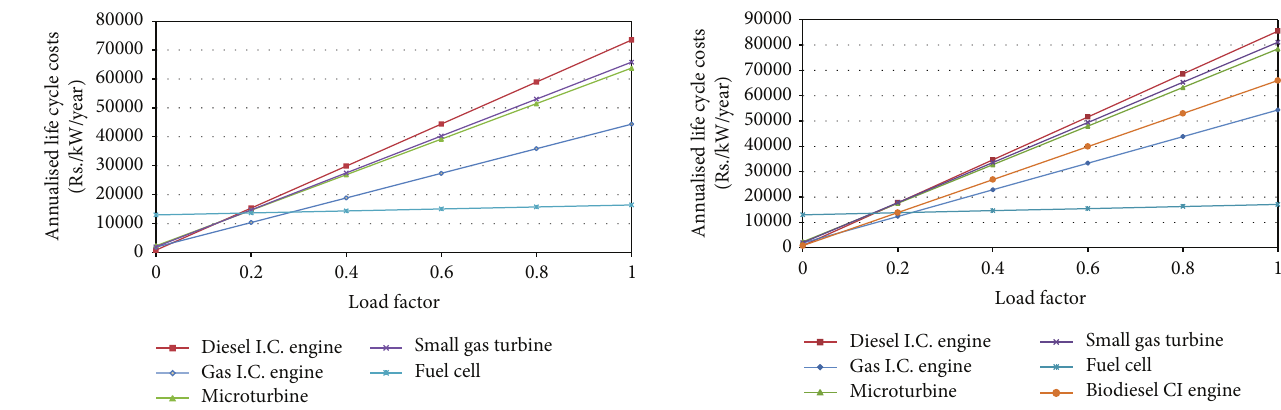
Figure 3: Comparison of annualised life cycle costs for different technological options when only DG is considered (discount rate (𝑑) = 10 %) for the month of January 2013. It is seen from Figure 2 that fuel cell is the cheapest option at load factor more than 0.3 in June 2011 and from Figure 3